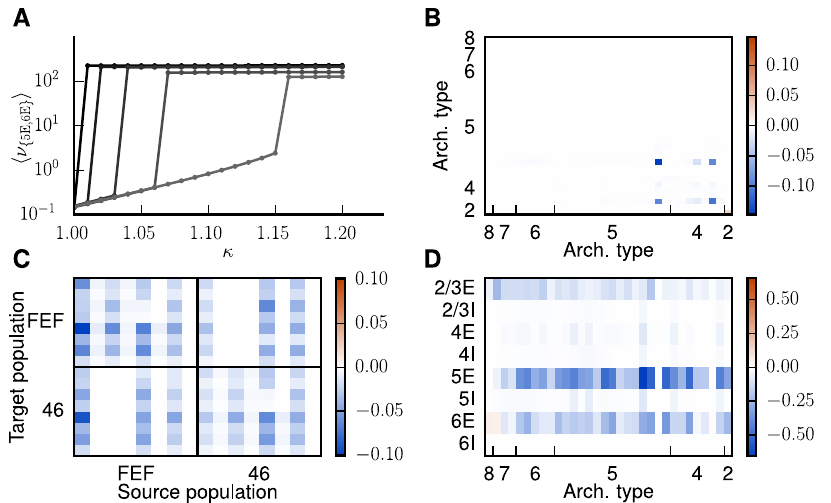
Fig 7. Altered phase space and modified connections. A Firing rates averaged across populations5E and 6E and across areas for different stages from the originalmodel (black) to iteration 4 (light gray) as a function of k , predictedby the mean-fieldtheory. B Relative changes in the indegree d K B in the first iteration. C Layer-specific relative changes d K areas FEF and 46, for the first iteration. Populationsare orderedfrom 2/3E (left) to 6I (right) on the horizontal axis and from 6I (bottom) to 2/3E (top) on the vertical axis as in panel D. D Relativechangesin